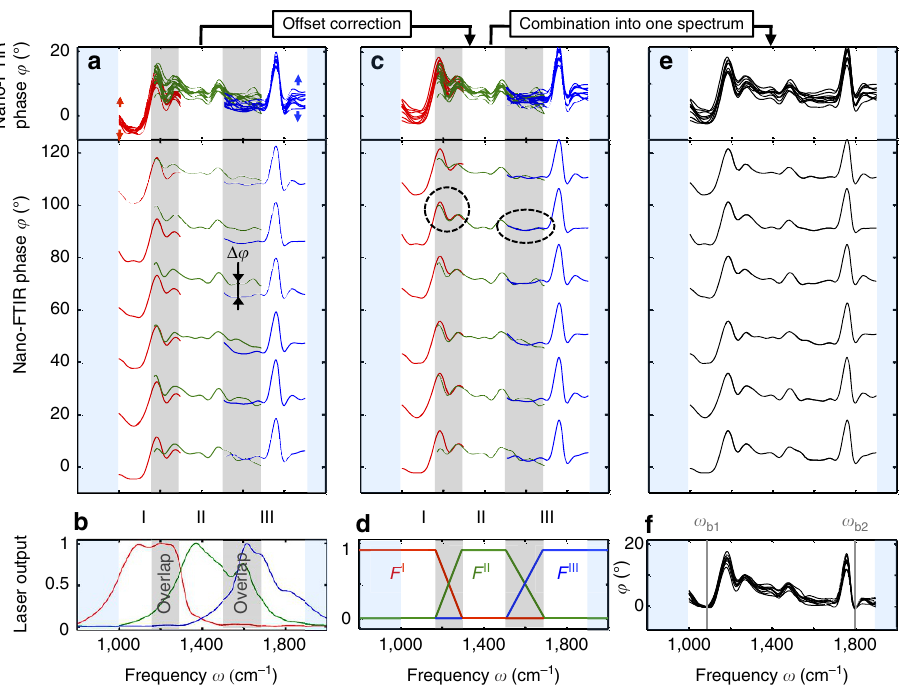
Figure 2 | Stitching of bandwidth-limited normalized nano-FTIR spectra. ( a ) Bandwidth-limited normalized nano-FTIR phase spectra from six subsequent pixels of the hyperspectral data cube shown in Fig. 1. ( b ) Laser output spectra. ( c ) Spectra of a after offset correction. ( d ) Functions F I , F II and F III . ( e ) Broadband nano-FTIR spectra after stitching. ( f ) Broadband nano-FTIR spectra after stitching and baseline correction. The top panels of a , c , e show all normalized spectra plotted on top of each other, while the bottom panels show the same spectra plotted for each pixel